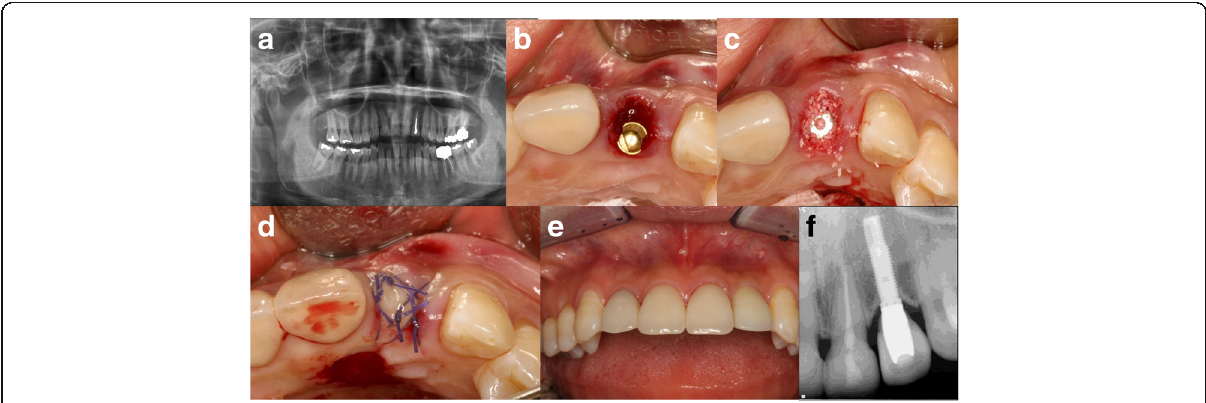
Fig. 1 Socket sealing surgery using a free palatal gingival graft. a The first panoramic radiograph. b Implant placement. c Bone graft. d Palatal free gingival graft. e Intraoral view 60 months after final prosthesis placement. f Periapical radiograph 84 months after final prosthesis